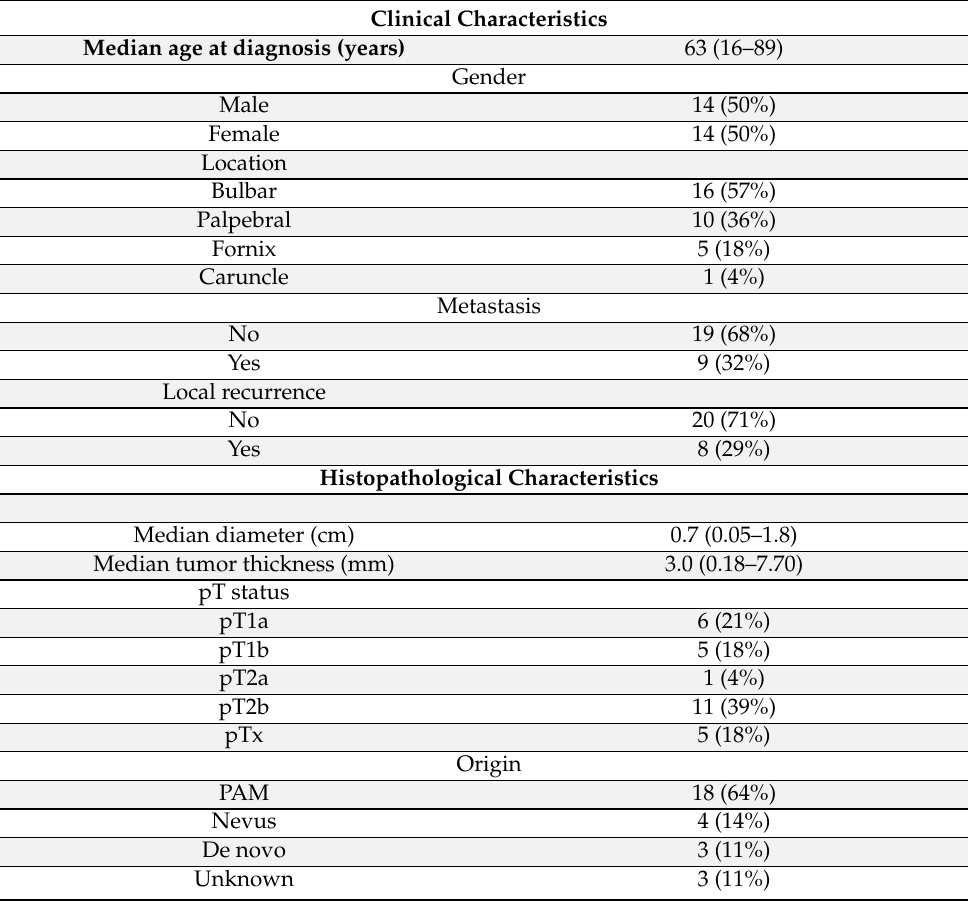
Table 1. Clinical and histopathological characteristics of the included conjunctival melanoma